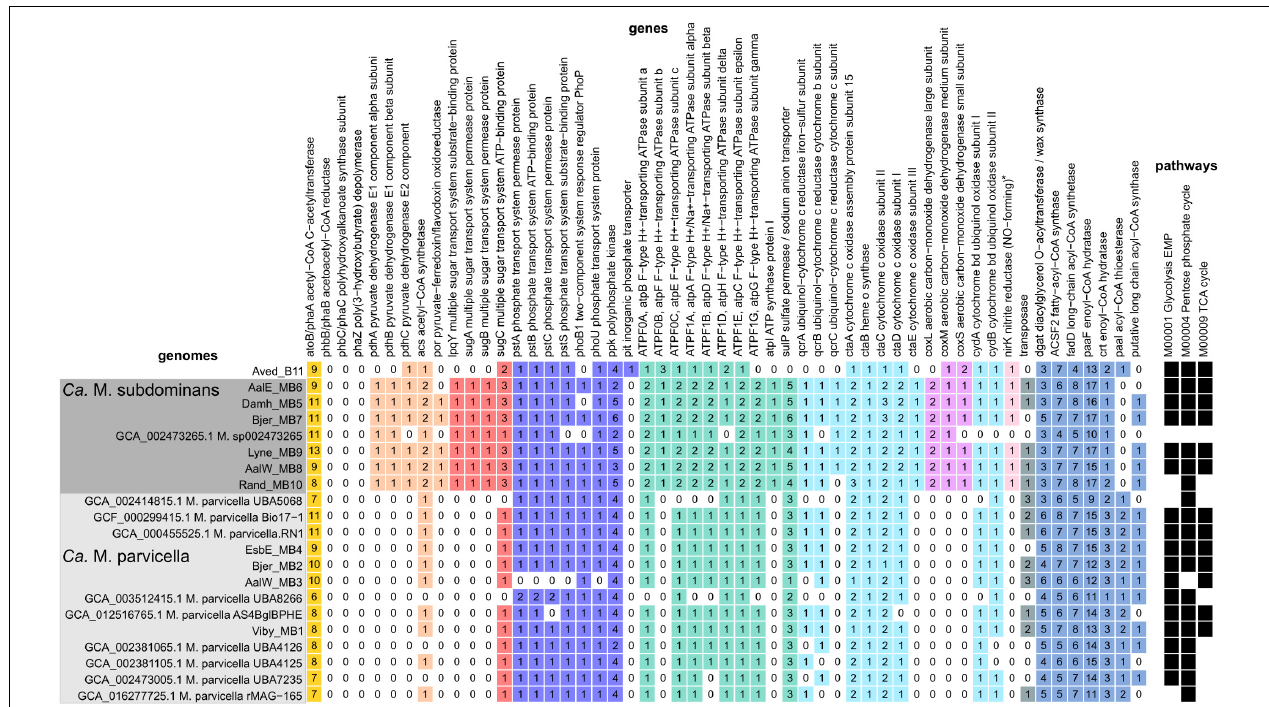
FIGURE 8 | Presence, absence and copy number of genes in the Ca. M. parvicella and Ca. M. subdominans MAGs and genomes discussed in this study. Genes were detected using the KO analysis, with the specific KOs shown in Supplementary Data 2 . The asterisk for nirK indicates that this gene was only detected in Ca. M. subdominans using this approach, but manual inspection of the Ca. M. parvicella RN1 genome in MAGE revealed a putative nirK , as found previously (McIlroy et al., 2013). The pathways indicate the KEGG modules with at least 80% completeness (black squares) for metabolisms described in the text ( Supplementary Data 3